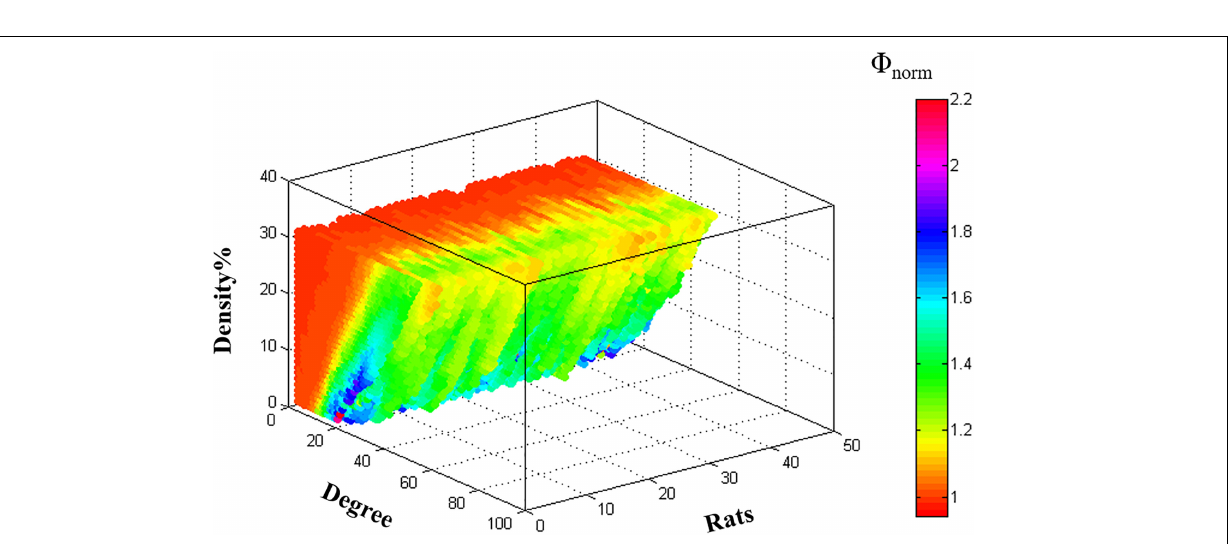
Frontiers in Aging Neuroscience |